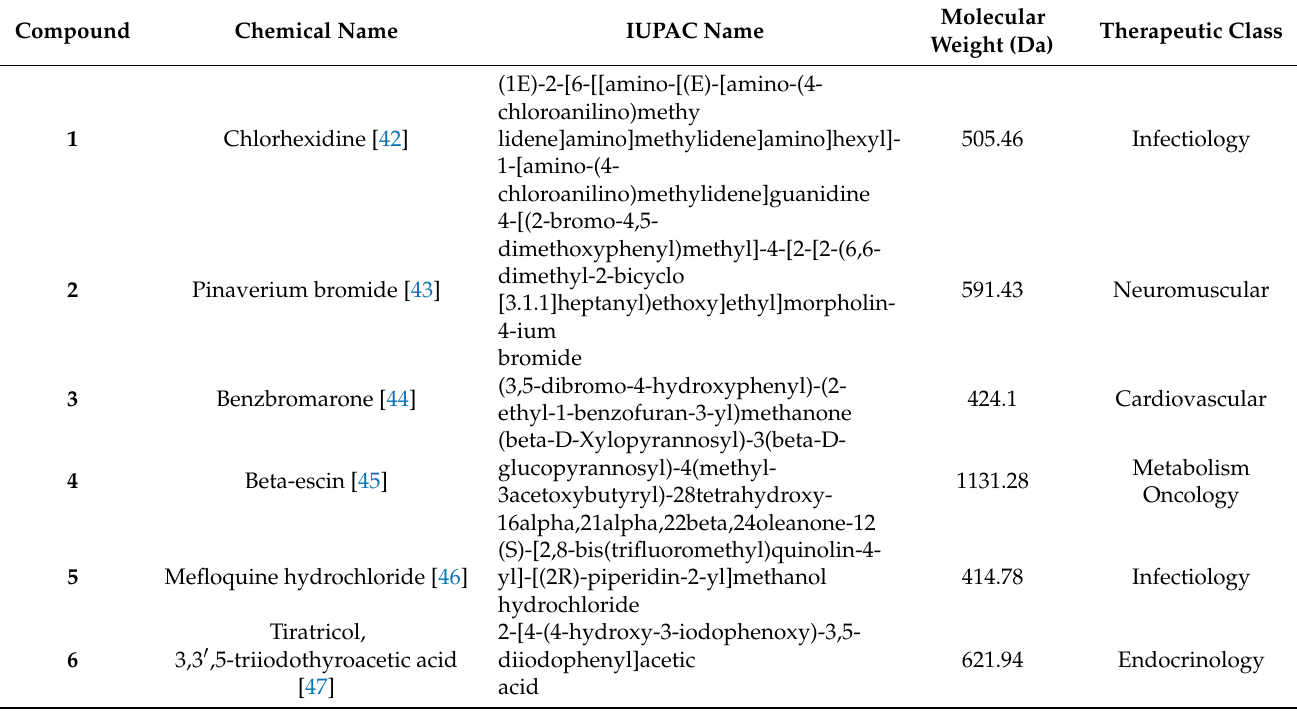
Table 1. Name, molecular weight, and therapeutic effect of the selected